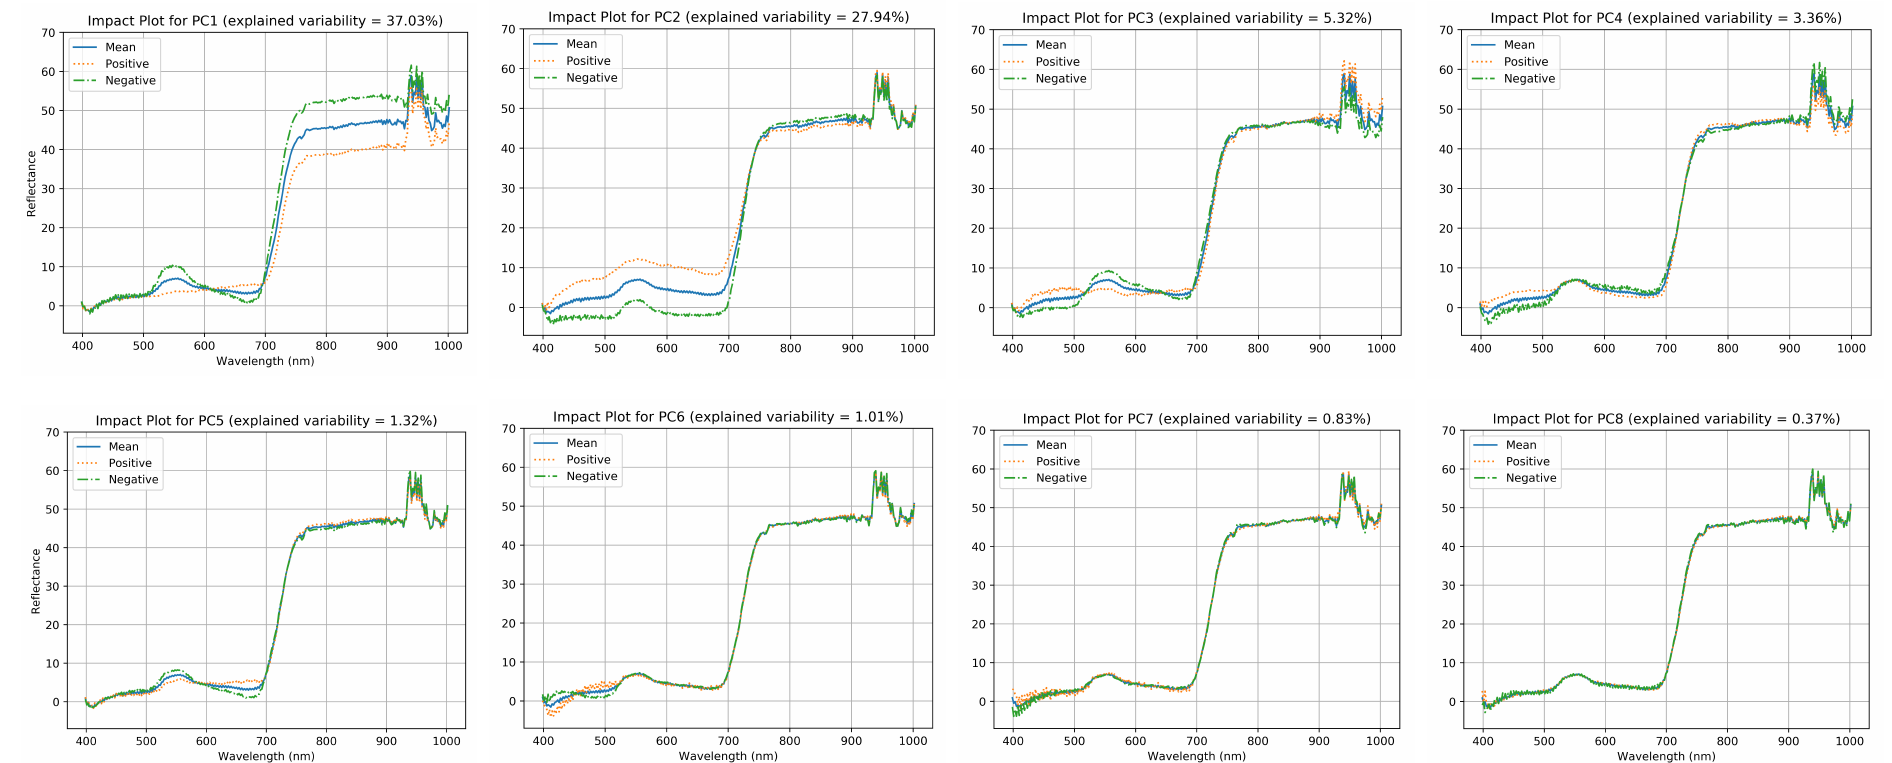
Figure 8. The first 10 principal components of a random flight from the 2019 data set. Please note that the first few PC’s contribute to the largest amount explained